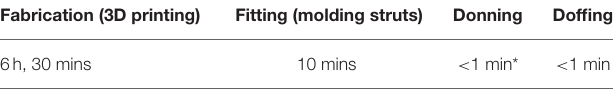
TABLE 1 | Time approximation, by process.